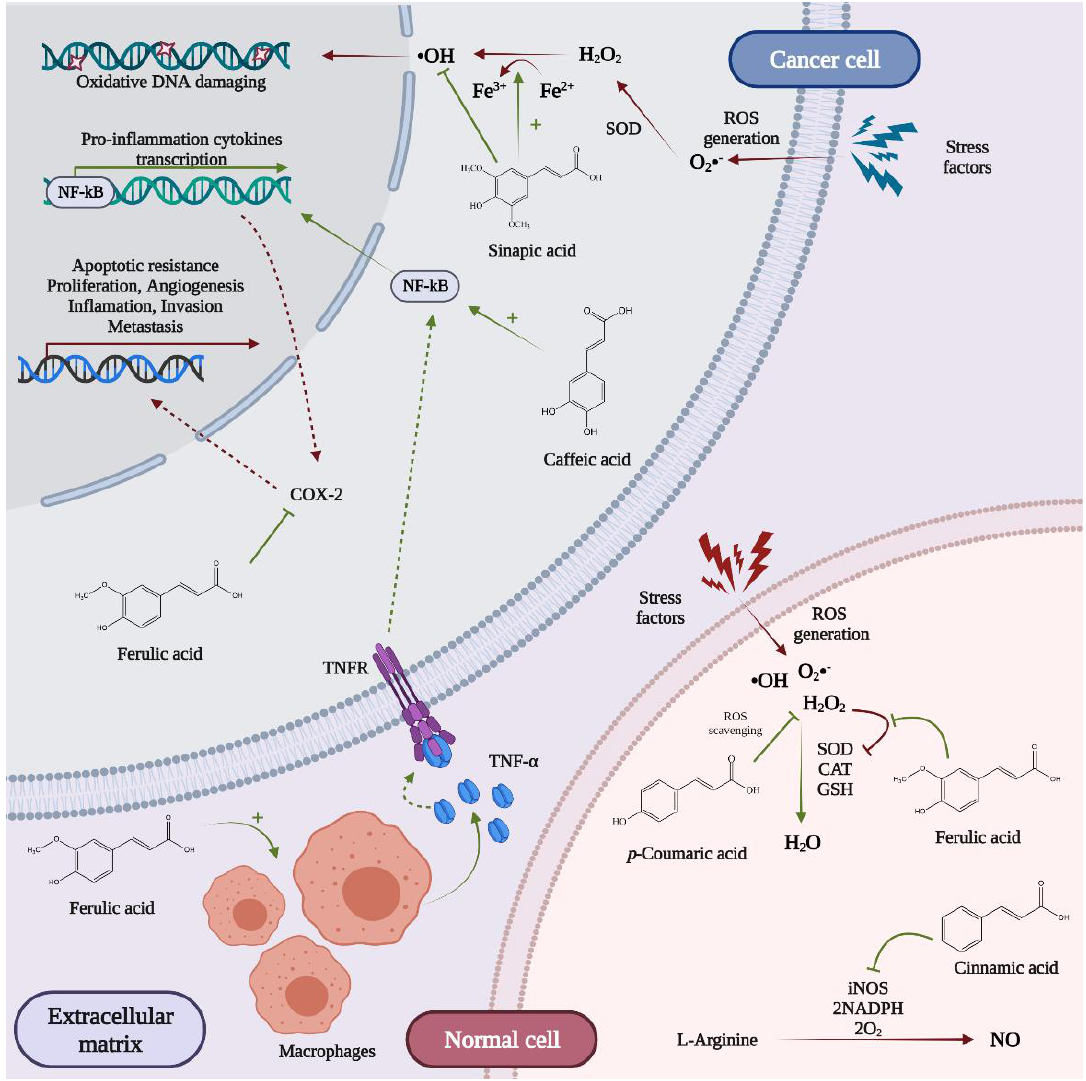
Figure 7. The main effects of phenolic compounds from cereal by-product extracts exert on normal and cancer cells.